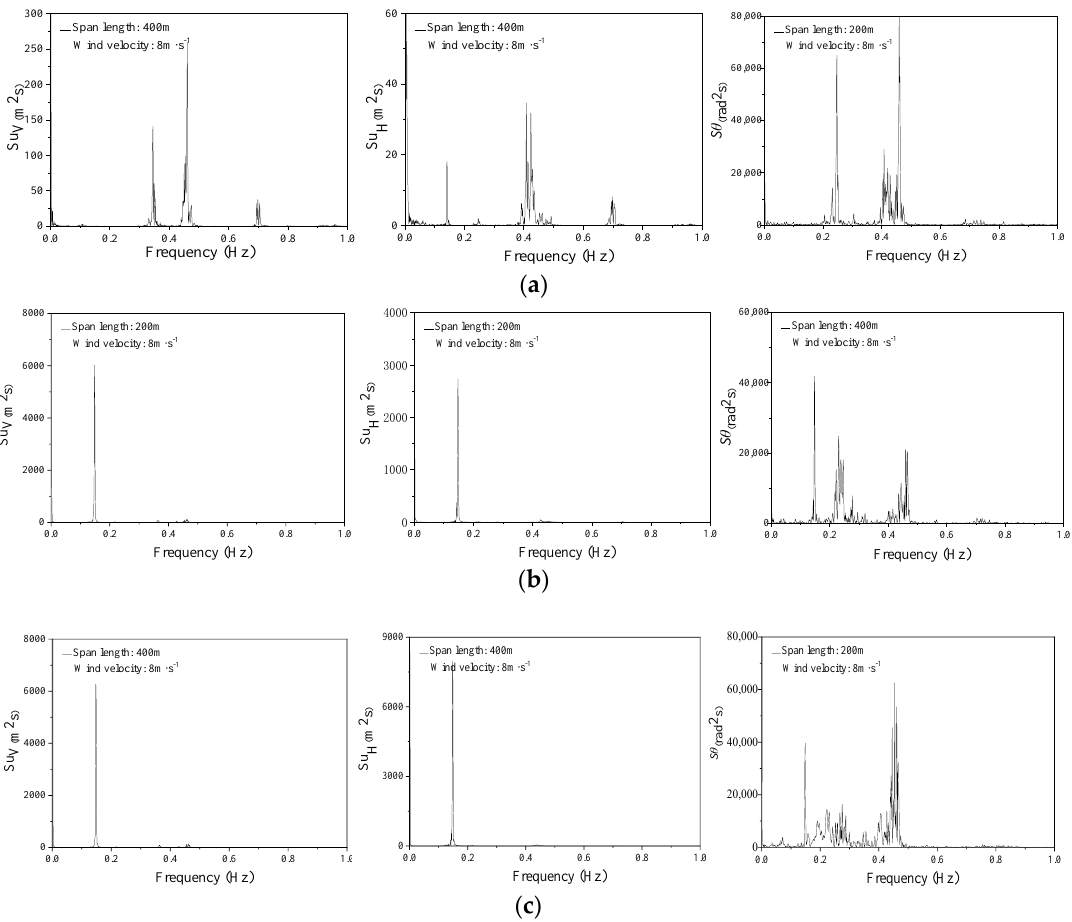
Figure 5. Midpoint spectrum diagram of each span of conductor under wind velocity of 8 m/s with span length: 400 m: ( a ) Spectrum diagram of the first span conductor; ( b ) Spectrum diagram of the second span conductor; ( c ) Spectrum diagram of the third span conductor.